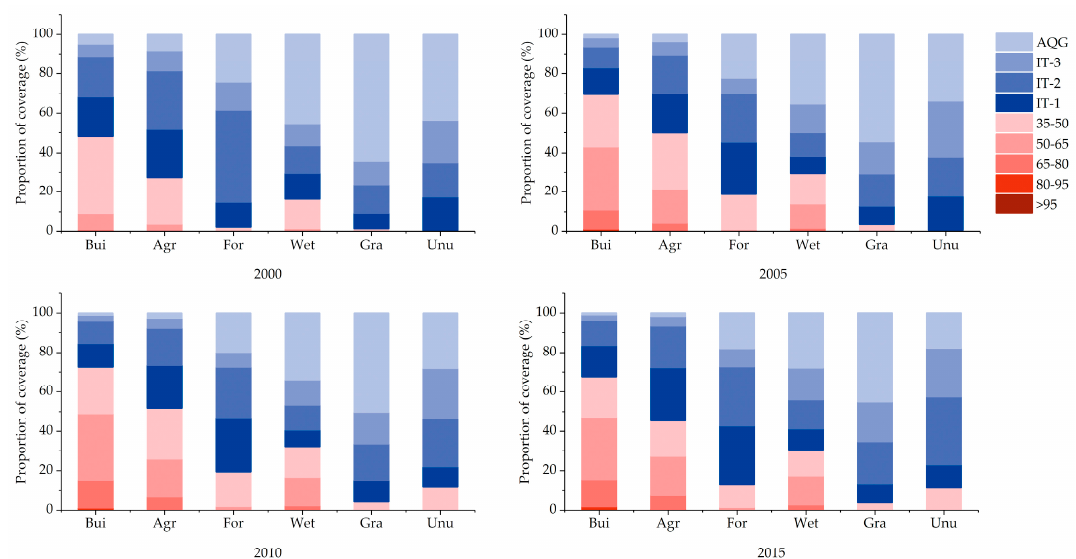
Figure 8. PM 2.5 concentration of different land use types in the year of 2000, 2005, 2010 and